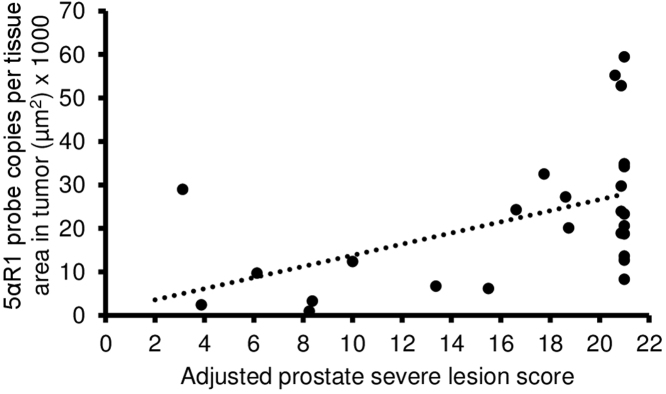
Spearman correlation coefficient (r) between 5α-reductase 1 (5αR1) in tumor and adjusted prostate lesion score severity. There was a significant positive correlation between 5α-reductase 1 in tumor and adjusted prostate lesion score severity (r = 0.41; p = 0.04).